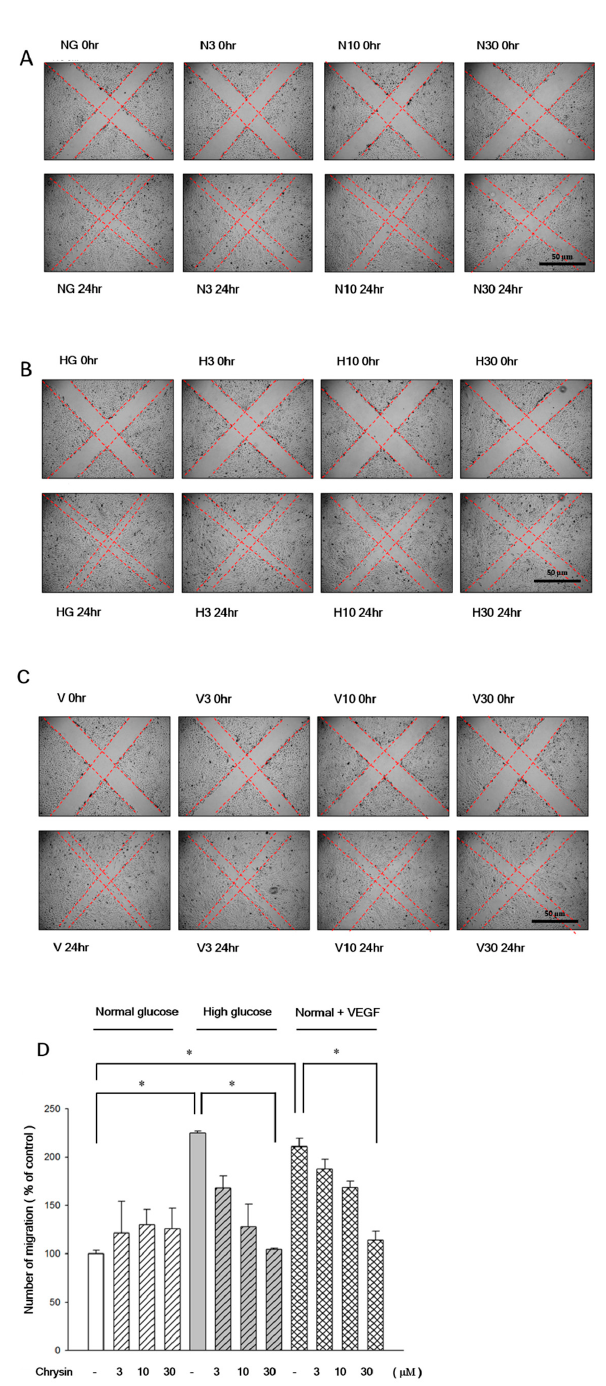
Figure 4. Chrysin inhibited high-glucose induced RF / 6A migration by scratch wound assay. The inhibitory e ff ects of RF / 6A cell migration treated with chrysin in normal glucose (5.5 mM), high glucose (30 mM), or normal glucose with 25 pg / mL VEGF through the wound healing assay. RF / 6A cells were treated chrysin at di ff erent concentrations (3, 10, 30 µ M) for 24 h and then cultured in normal glucose ( A ) high glucose ( B ) or normal glucose with VEGF ( C ) for 24 h. The wound-healing assay was performed for cell migration. ( D ) The quantitative results of the wound healing assay for RF / 6A cells treated chrysin and cultured in normal glucose, high glucose, or normal glucose with VEGF. Results are expressed as a percentage of control and mean ± SE. * p < 0.05, vs. control, * p < 0.05, vs. high glucose group control, * p < 0.05, vs. normal with VEGF group control. Scale bar, 50 µ